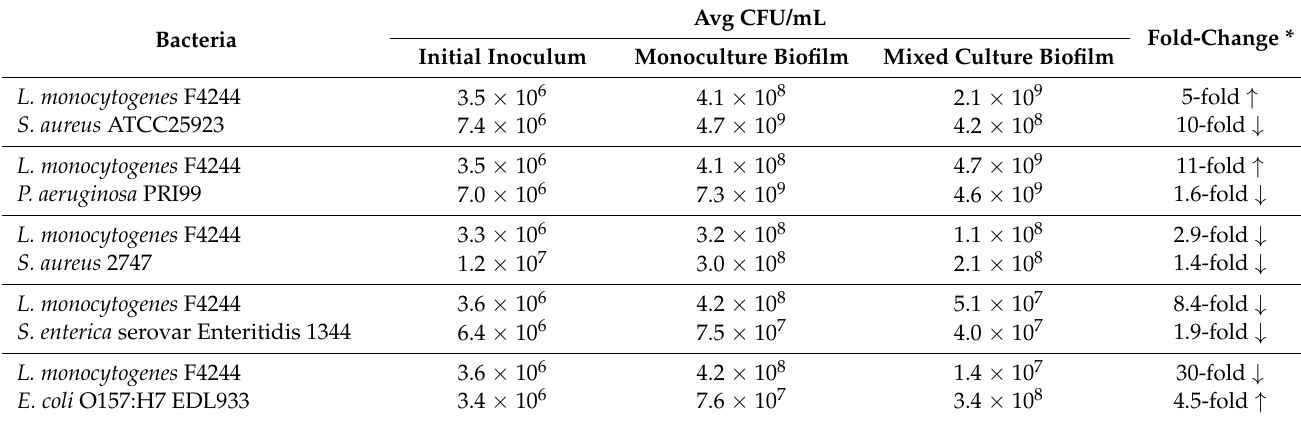
Table 2. Bacterial counts in mixed-culture